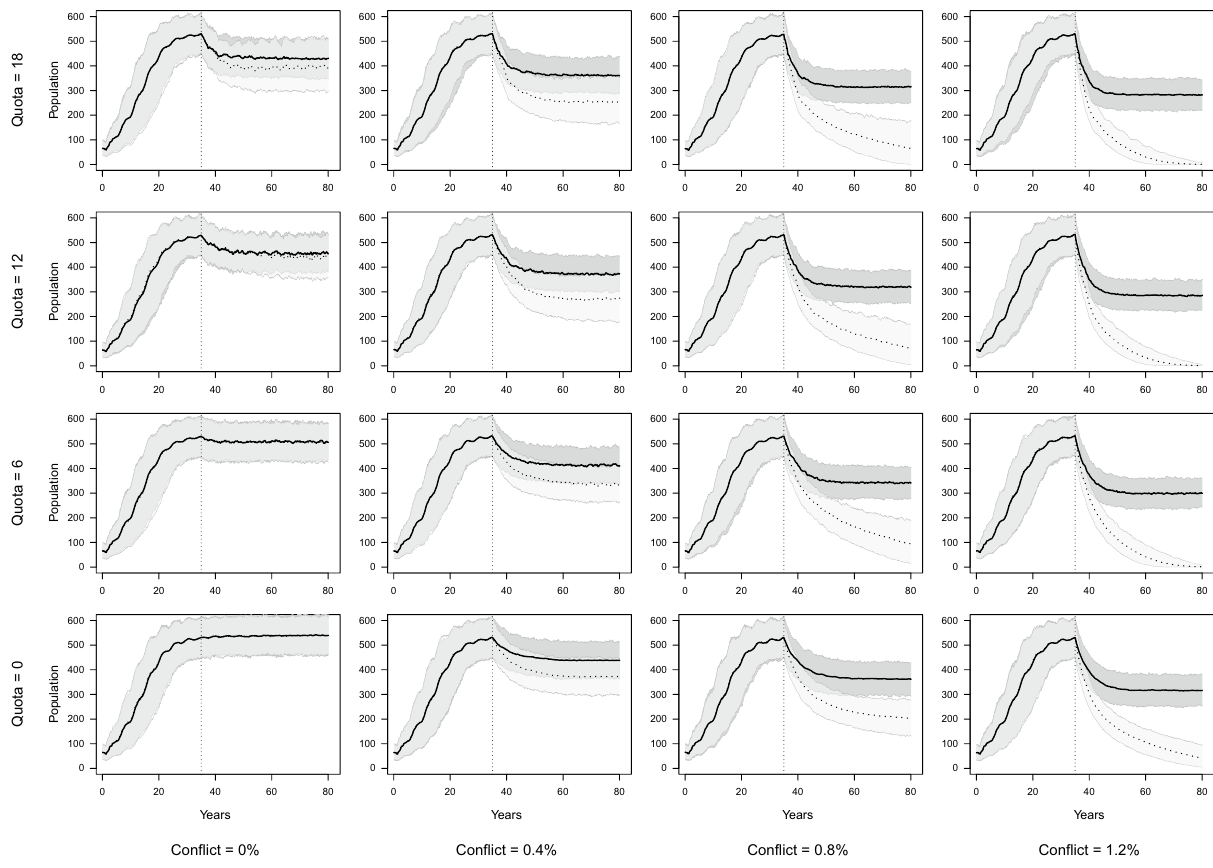
Figure 2. Effect of varying hunting quotas and conflict mortality rates on lion population persistence. Solid line: 25 of 40 (63%) prides vulnerable to edge effects (hunting and conflict), approximating the impacts experienced by the HNP population. Dotted line: All 40 prides in the simulation impacted by hunting and conflict mortality. Only male lions, ≥ 6 years old were eligible to be hunted. The black lines represent the mean and the light grey areas the 95% confidence interval of simulations. The vertical dotted line marks the point at which test scenarios were implemented after the population had reached its asymptotic